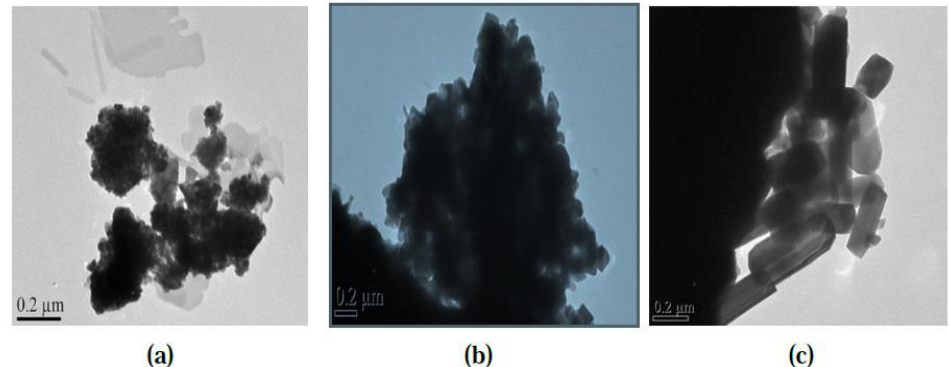
Figure 10. TEM images of LaFeO 3 nanoparticles calcined at (a) 400 °C (b) 450 °C (c) 500 °C